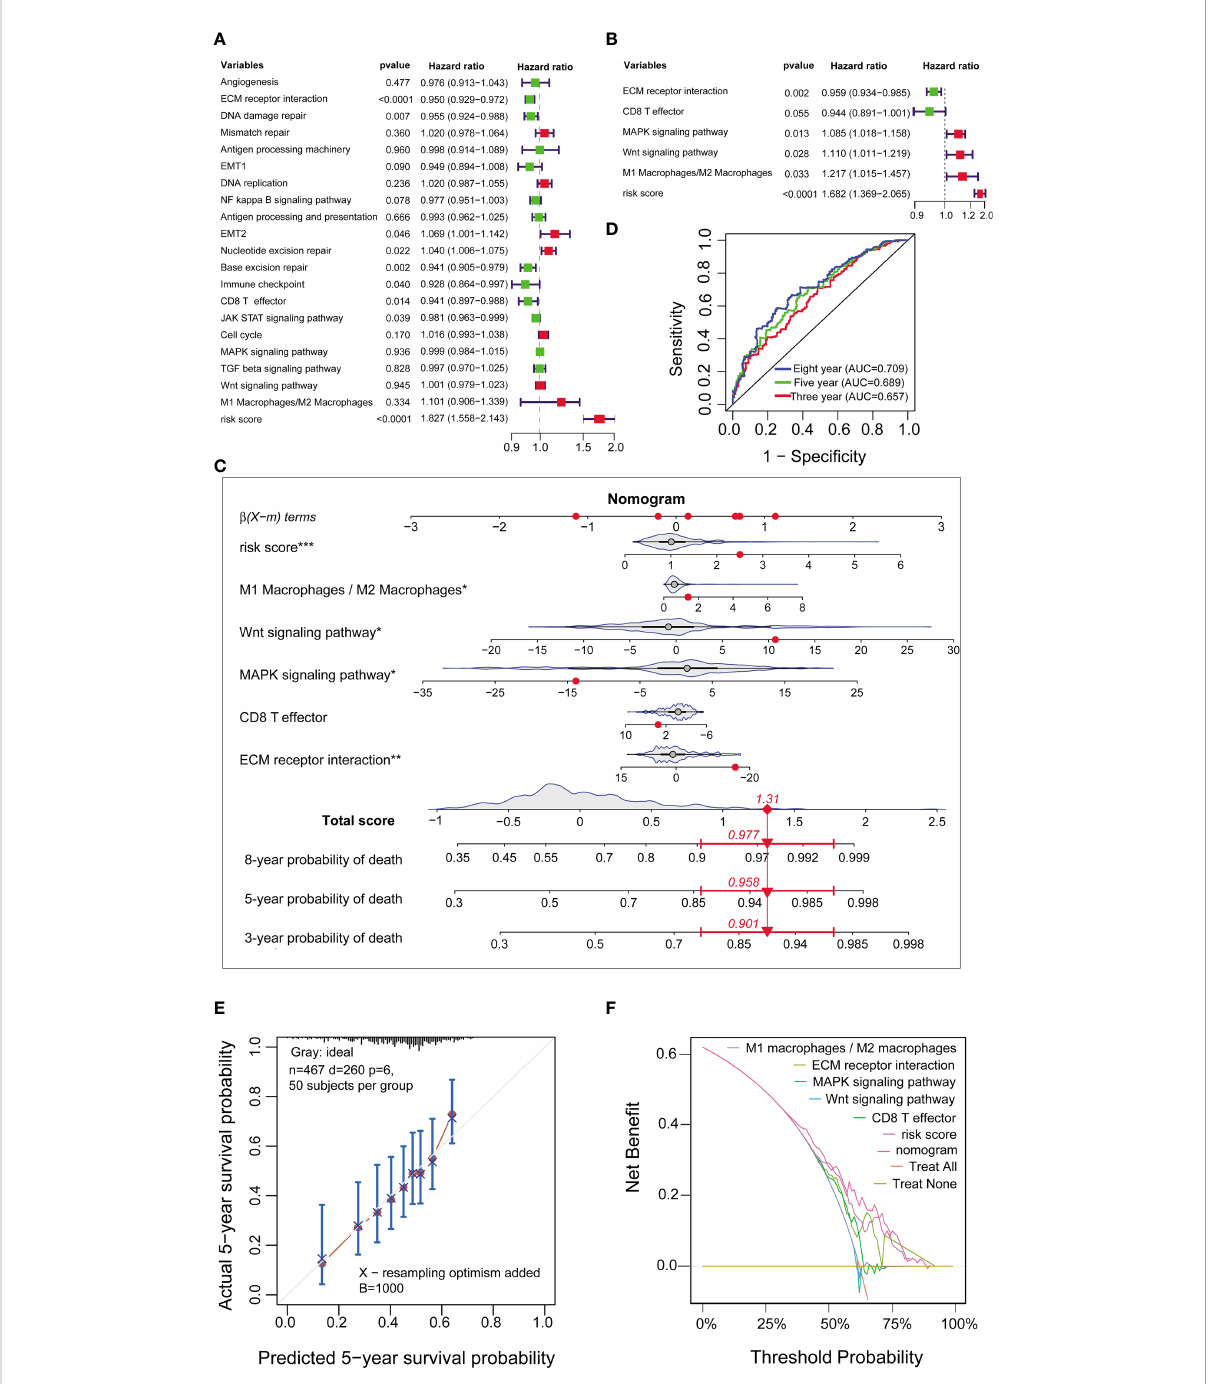
FIGURE 7 Construction of a nomogram for prognosis in FMAC. (A) The univariate and (B) multivariable Cox regression for the risk score and essential signaling pathways in FMAC. (C) The nomogram constructed by six variables. The red dot represents the risk score corresponding to the value of the independent variable. According to the total scores of the nomogram, the three-year, fi ve-year and eight-year death probability in randomly selected the 400th patient being 0.901, 0.958 and 0.977, respectively. (D) ROCs for three-year, fi ve-year and eight-year death probability of the nomogram. (E) Calibration curves of the predicted fi ve-year survival probability and actual fi ve-year survival probability. The gray line indicates ideal fi t; the circle indicates the predicted fi ve-year survival probability of nomogram; the stars indicate bootstrap correction estimates, and the error bars indicate the 95% CI of these estimates. (F) Decision curves for the nomogram, the risk score of nine prediction model genes and other four